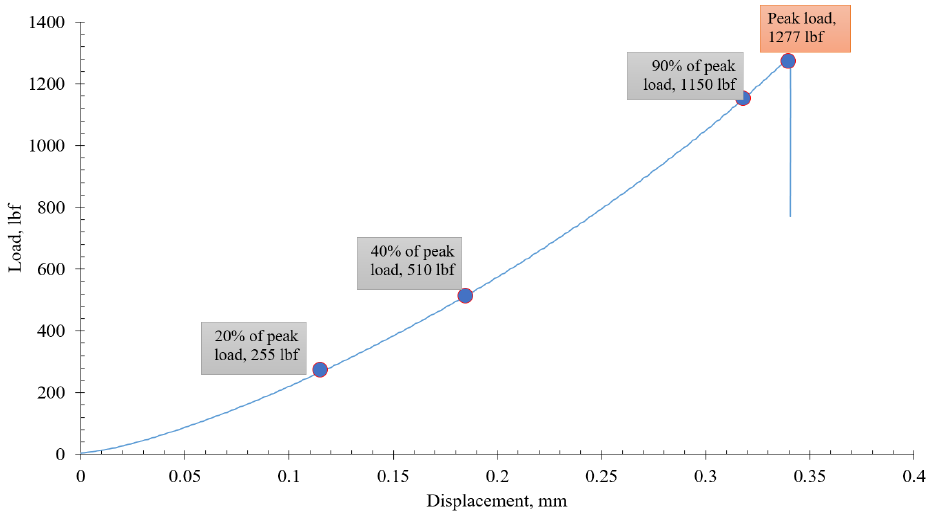
Figure 7. Load–displacement nature for the Spider Berea sandstone.